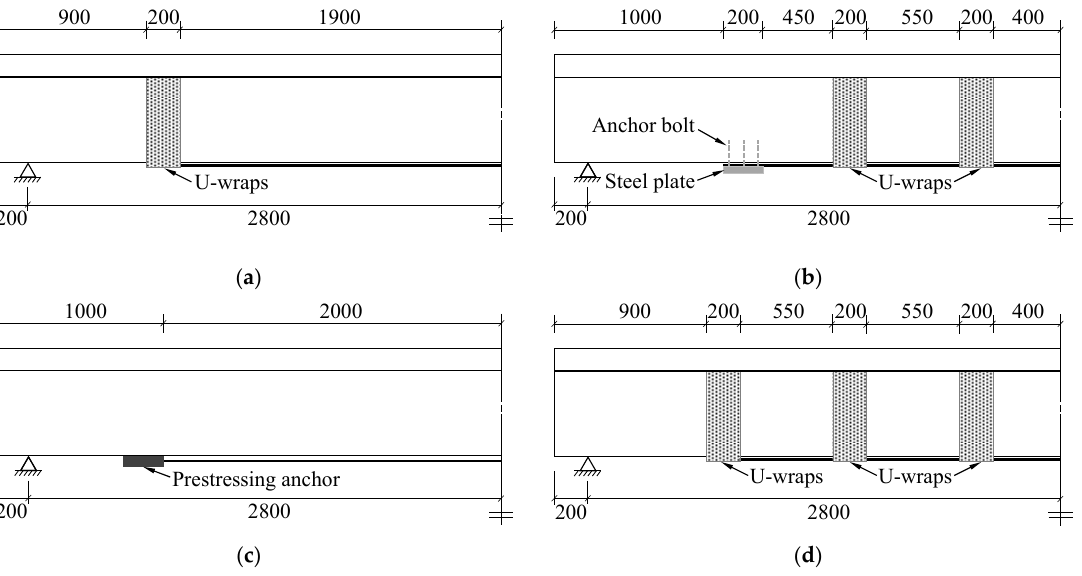
Figure 2. Anchorage methods of the specimens (unit in mm): ( a ) BS-1; ( b ) BS-2; ( c ) BS-3, BP-1, and BP-2; ( d ) BS-4 (unit in mm).